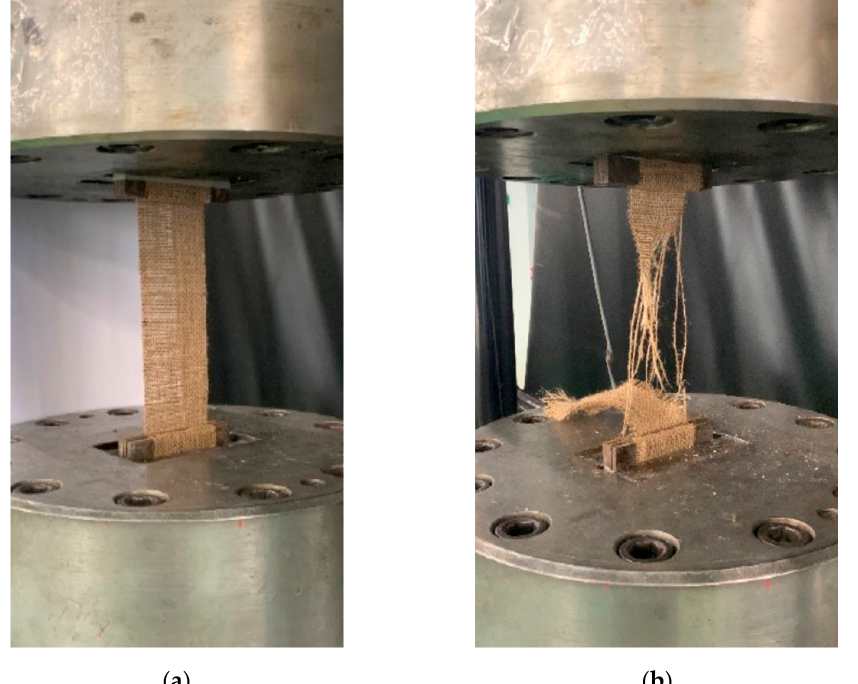
Figure 3. Mechanical characterisation of natural textile (Jute): Before ( a ) and After ( b ) testing.